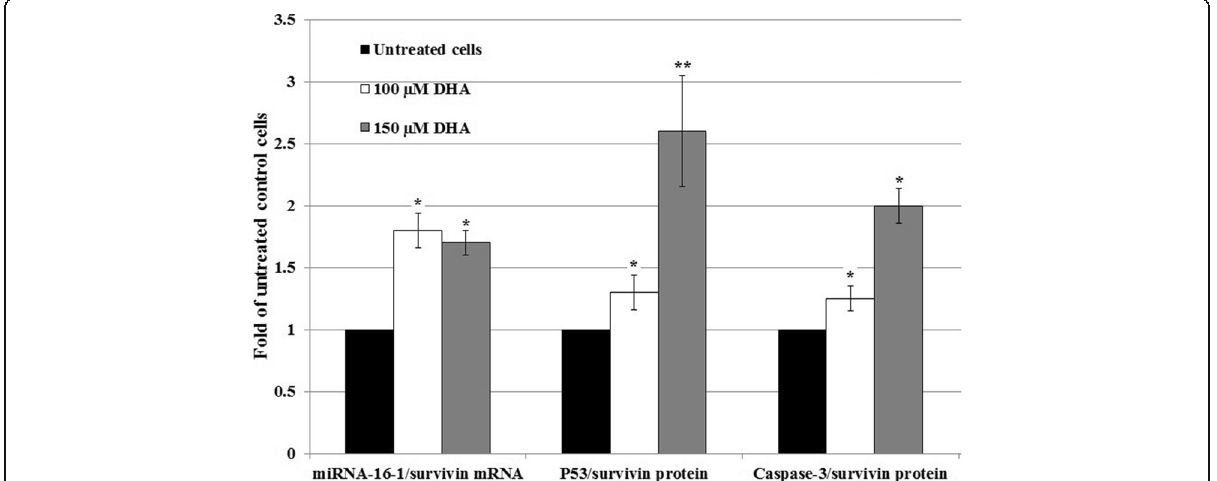
Fig. 8 Evaluation of the microRNA-16-1/survivin mRNA, p53/survivin, and caspase-3/survivin protein ratios in DHA-treated cells. 5×10 5 HCT-116 cells/well were treated with different DHA concentrations for 48 h and microRNA-16-1, p53, survivin, and caspase-3 expression levels were measured. Thereafter, microRNA-16-1/survivin mRNA, p53/survivin, and caspase-3/survivin protein ratios were calculated. The results were presented as mean±SD of two independent experiments with triplicate assays. * P <0.05 and ** P <0.01 vs. untreated control